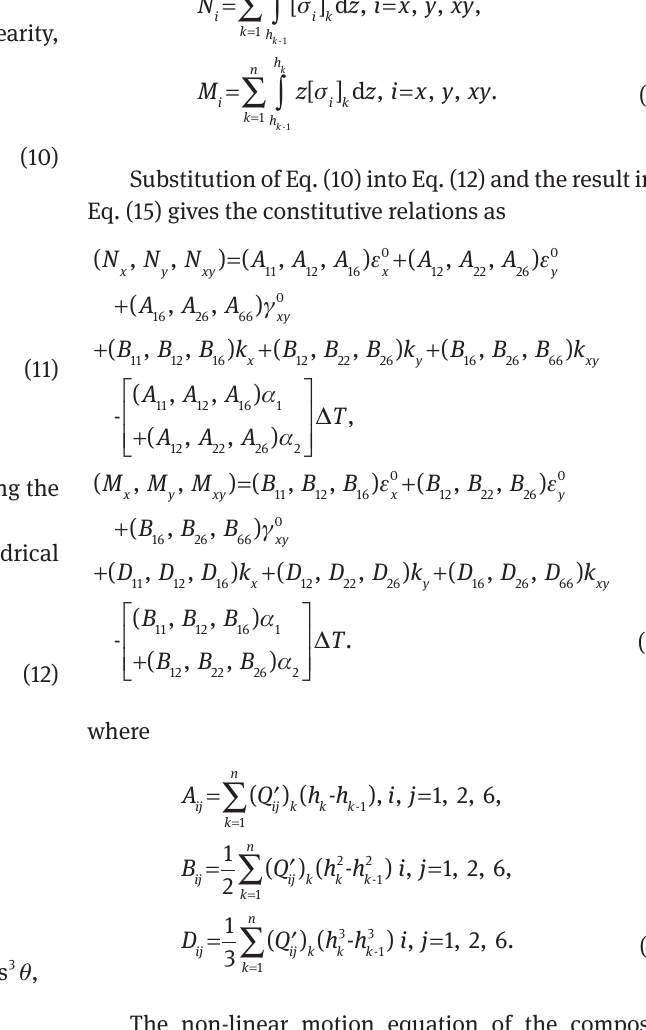
Figure 1: Geometry and coordinate system of the three-phase lami- nated nanocomposite cylindrical panel on elastic